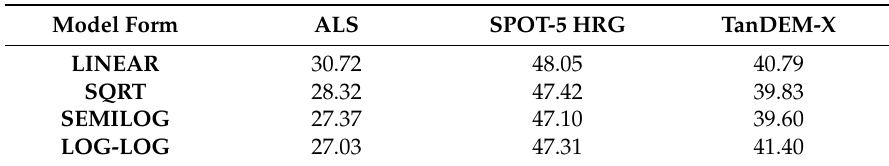
Table B3. Relative RMSE (%) values for the volume per hectare variable of interest. Results for models based on ALS- and SPOT-5-based RS data are given for data collected in 2010 and results for TanDEM-X data are calculated using data from 2011.